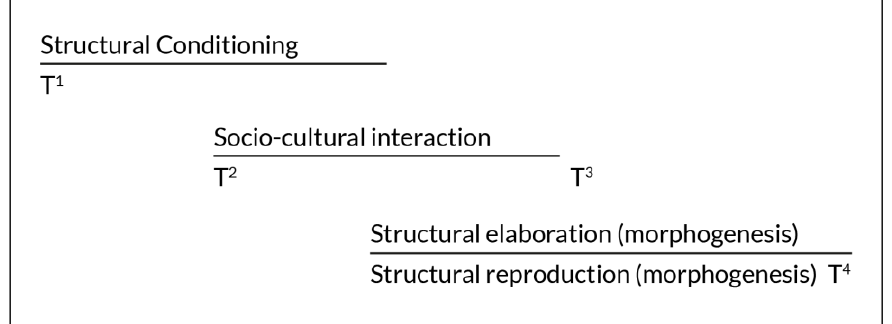
Figure 1 : Stages of the basic morphogenetic